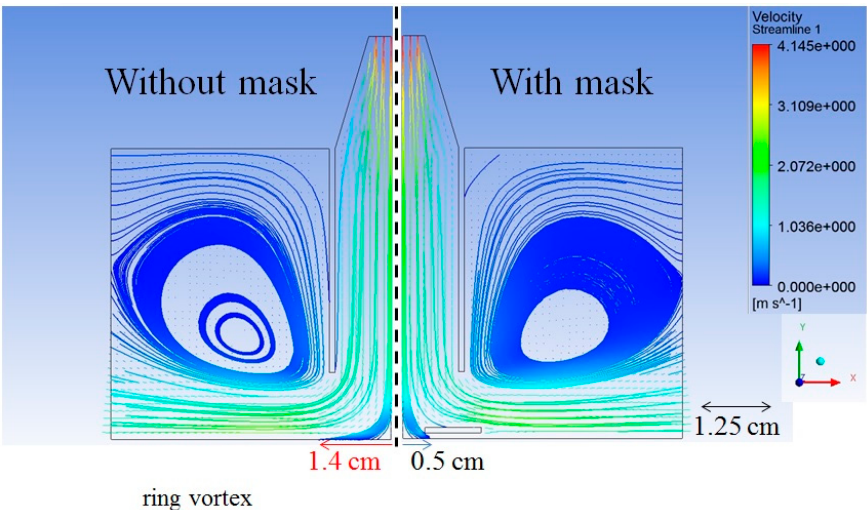
Figure 6. Simulation of flow field on the chip surface with and without mask.